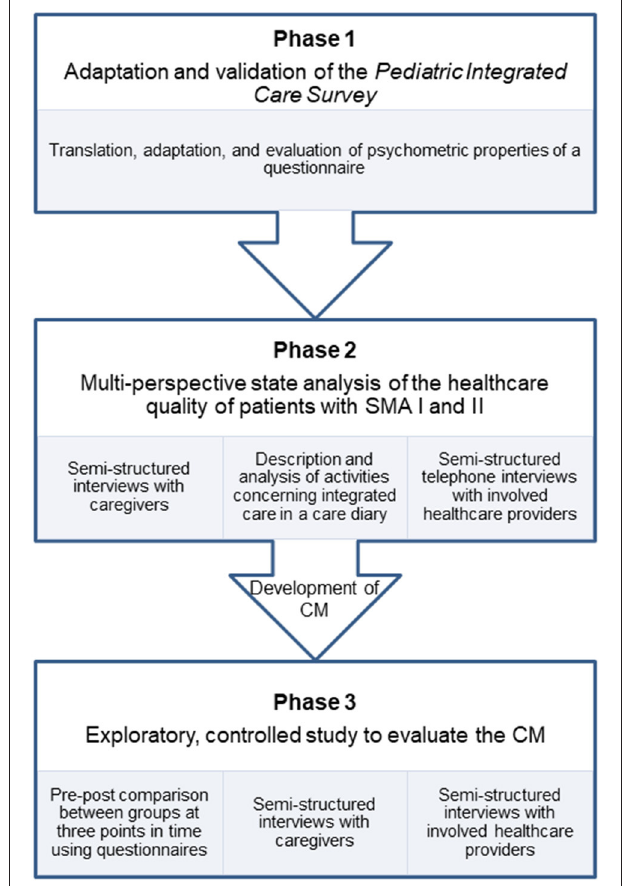
FIGURE 1 | Flow chart of the three phases of the